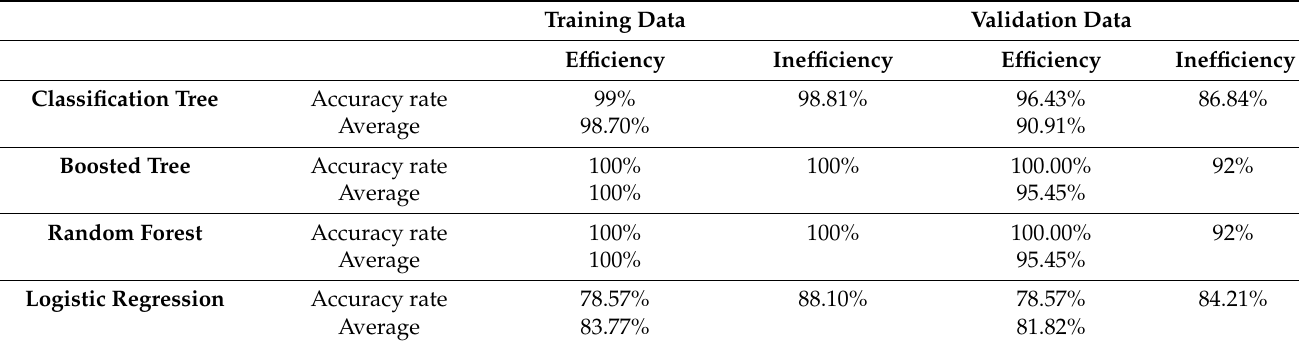
Table 8. The accuracy results for the four different